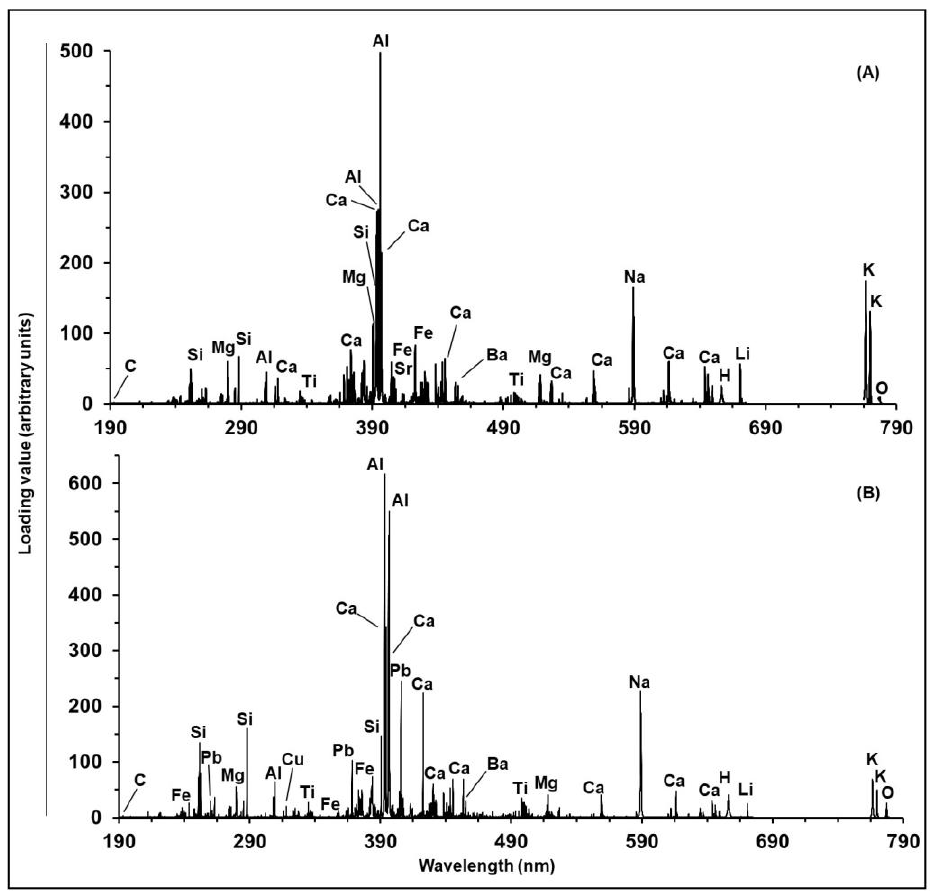
Figure 6. Plot of loading vectors versus wavelength (nm) for the LIBS analysis of the New Mexico ( A ) and military installation ( B ) soil samples. The loading values that have the largest impact on the PLSDA model are labeled with the element associated with that emission line.